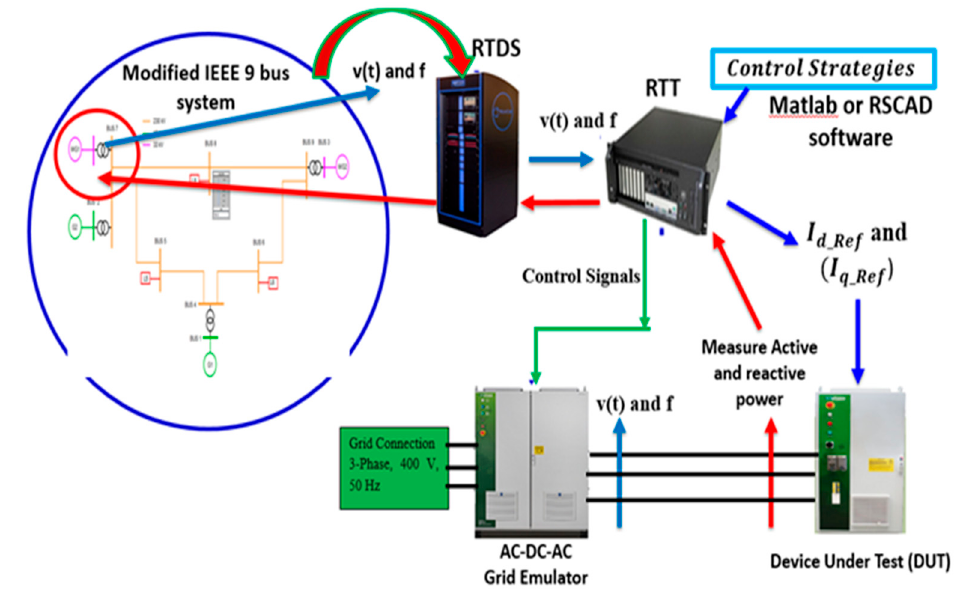
Figure 11. Use of the PHIL setup for the evaluation of FAPR strategies.